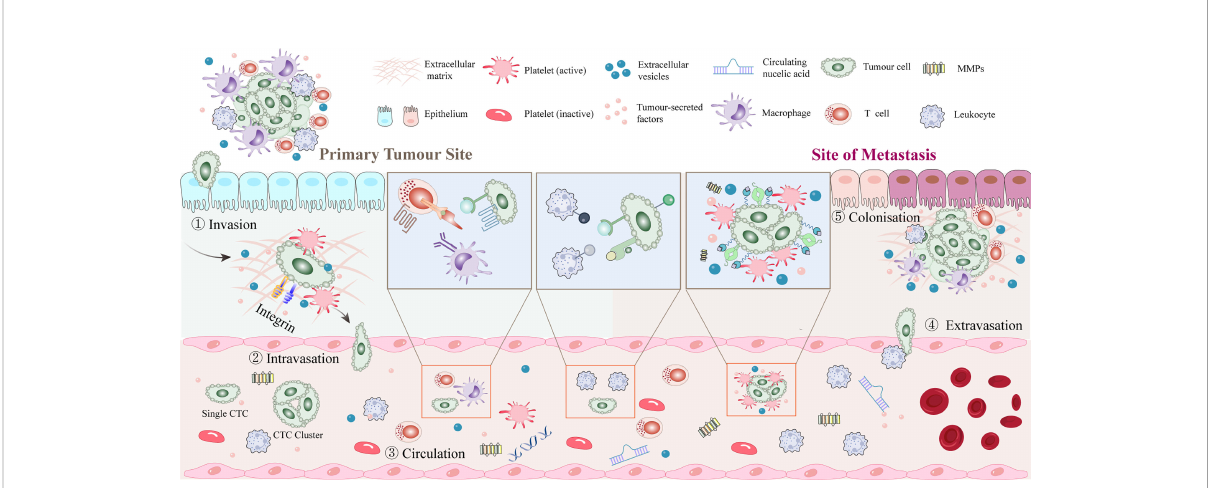
FIGURE 2 Platelet-tumor cell interactions in early steps of the metastatic cascade. After dissociating from the primary tumor, tumor cells enter the blood vessels and rapidly pass through the circulation into the vasculature of secondary organs. Platelets aggregate around CTCs or around stalled tumor cells to form a platelet protective barrier. Tumor cells promote platelet induction of NETs. Extravasation typically occurs within 1 to 3 days of the initial arrest, seeding into the stroma of the target tissue or organ and recruiting myeloid cells to the early metastatic niche. Tumor cells may remain dormant or start growing again to initiate metastases, with only a few cells completing the metastatic cascade and forming clinically relevant metastatic tumors. CTC, circulating tumor cell; NET, neutrophil extracellular trap.